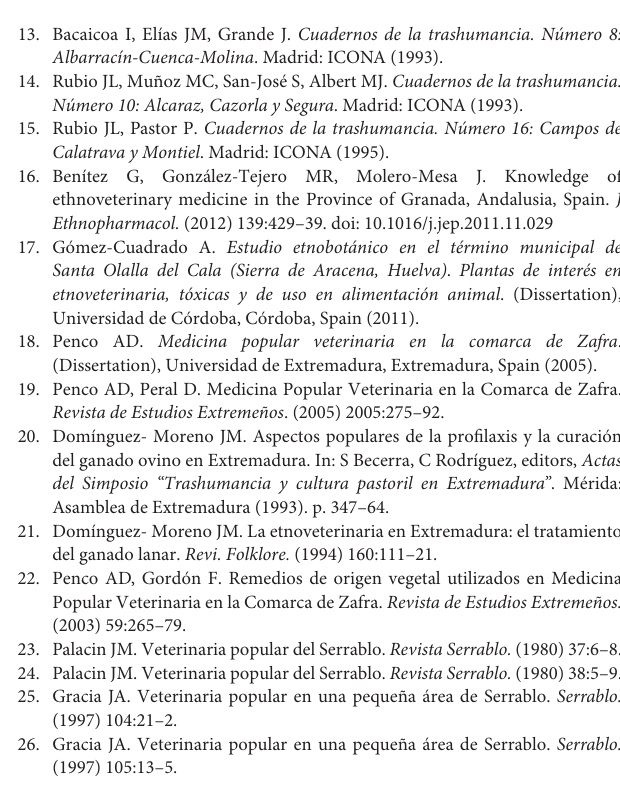
Supplementary Table 1 | Crude data with description of the formulas and simple remedies analyzed. Supplementary Table 2 | List of voucher